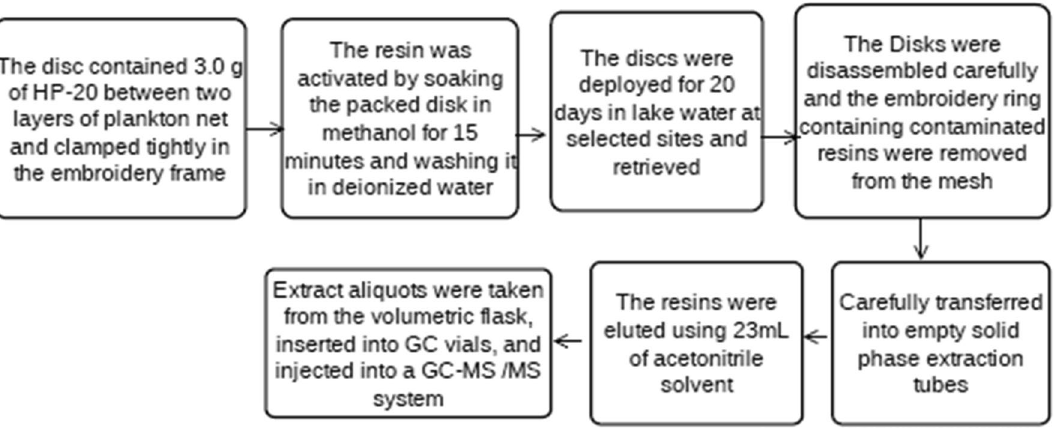
Fig. 3 Passive sampler deployment, extraction of pesticide from HP-20 resin, and analysis